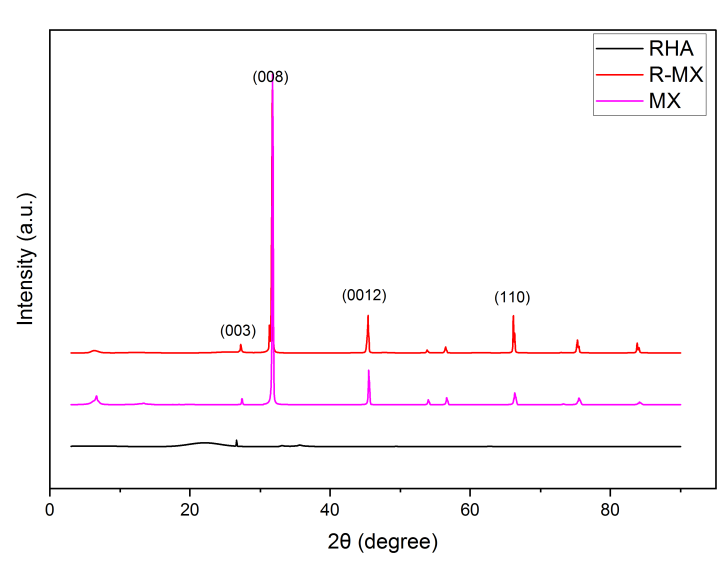
Figure 4. XRD analysis of plain RHA and R-MX composites (JCPDS no. 16–0152).